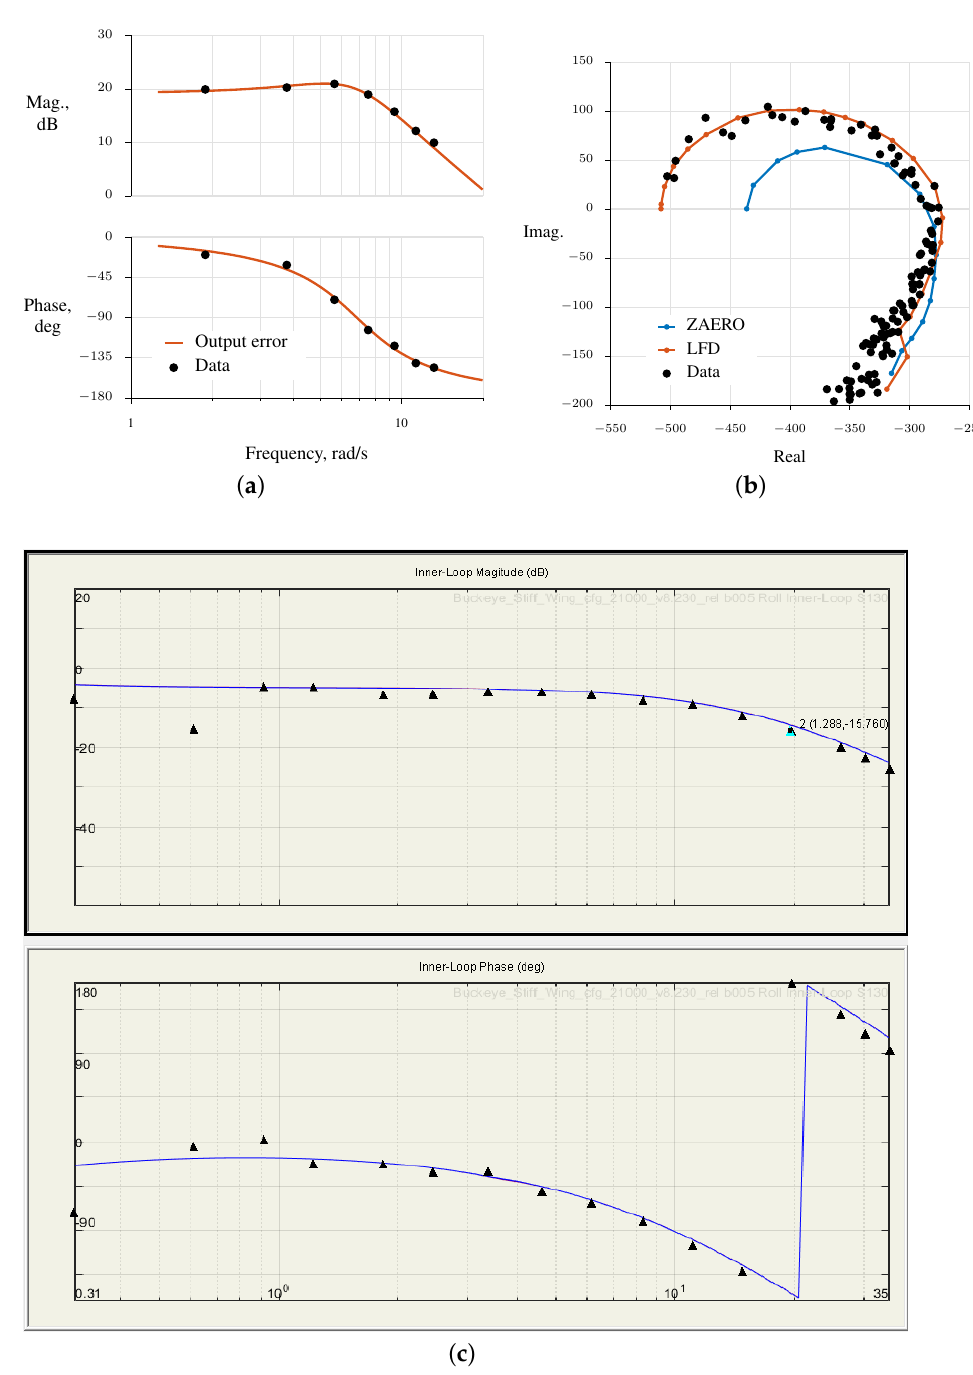
Figure 4. Examples of frequency response estimates using multisine inputs and the direct approach: ( a ) elevator to vertical accelerometer frequency response for the NASA T-2 airplane used in AirSTAR flight research; ( b ) reduced order modeling for a CFD analysis of the IAWTM wind tunnel test article; ( c ) control room display of the X-56A roll stability margin loop during Flight 8 with the NASA control laws (image courtesy of Matthew Boucher, NASA